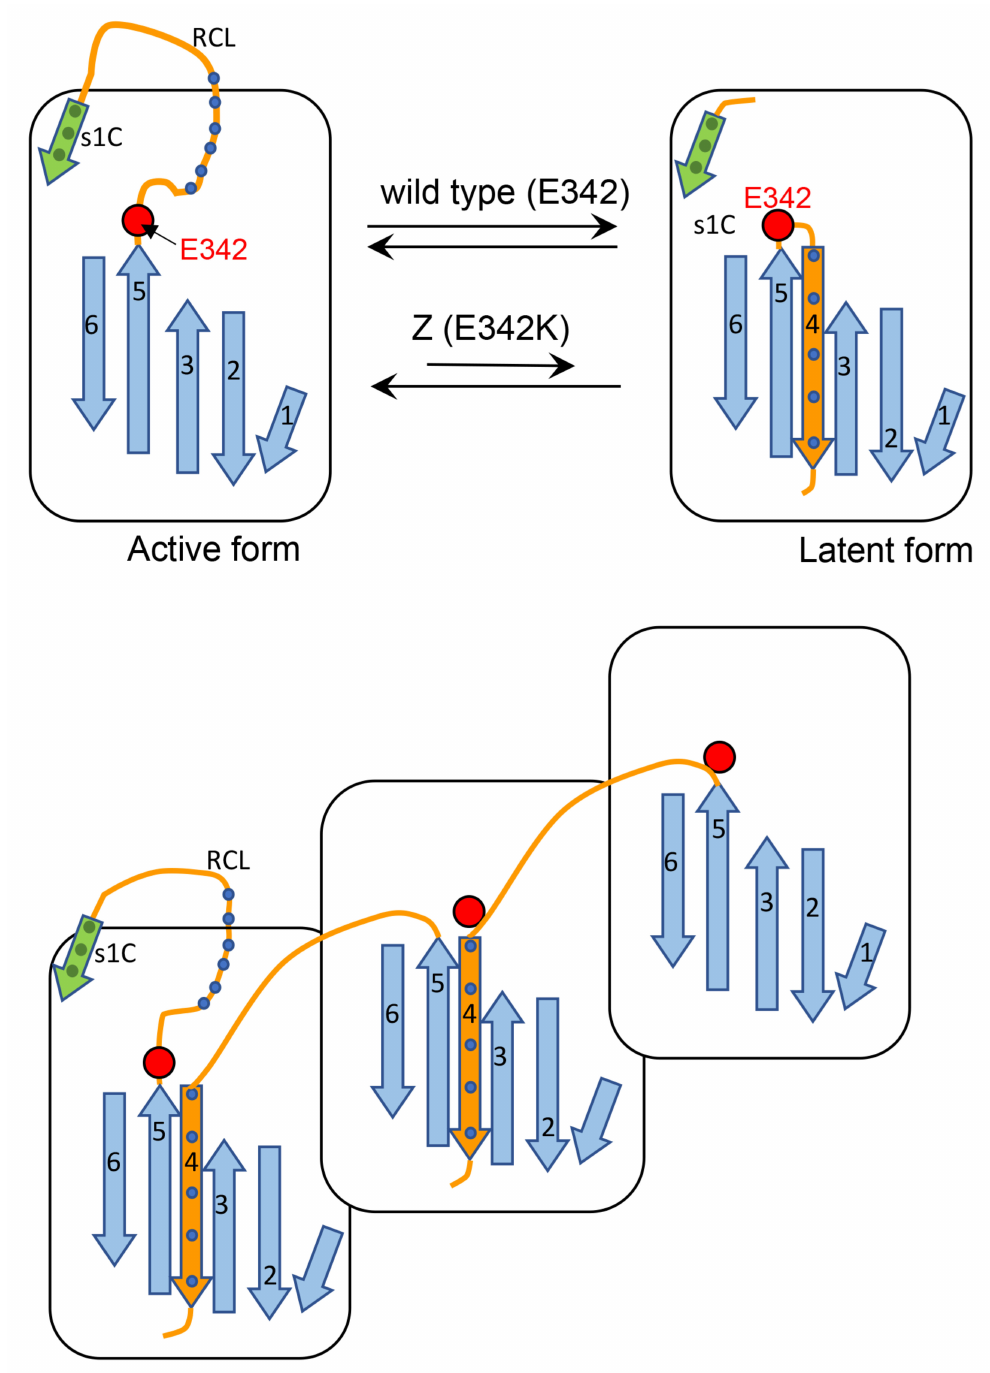
Figure 13. Schematic representation of the intramolecular insertion of the polymerized RCL peptide into the beta-sheet of AAT between beta—strand 5 with the rest of the protein structure. This results in a decreased function as a hinge of the affected site makes the thermodynamic equilibrium of the intramolecular RCL insertion less favorable ( Upper panel ). The alternative intermolecular RCL insertion allows the mutant to produce elongating multi-AAT structures. Also M AAT can engage in intermolecular insertion forming mixed M-Z aggregates, but it can dynamically escape by switching to more stable intramolecular RCL insertion, which reverses the growth of aggregates and partially rescues Z AAT ( Lower panel